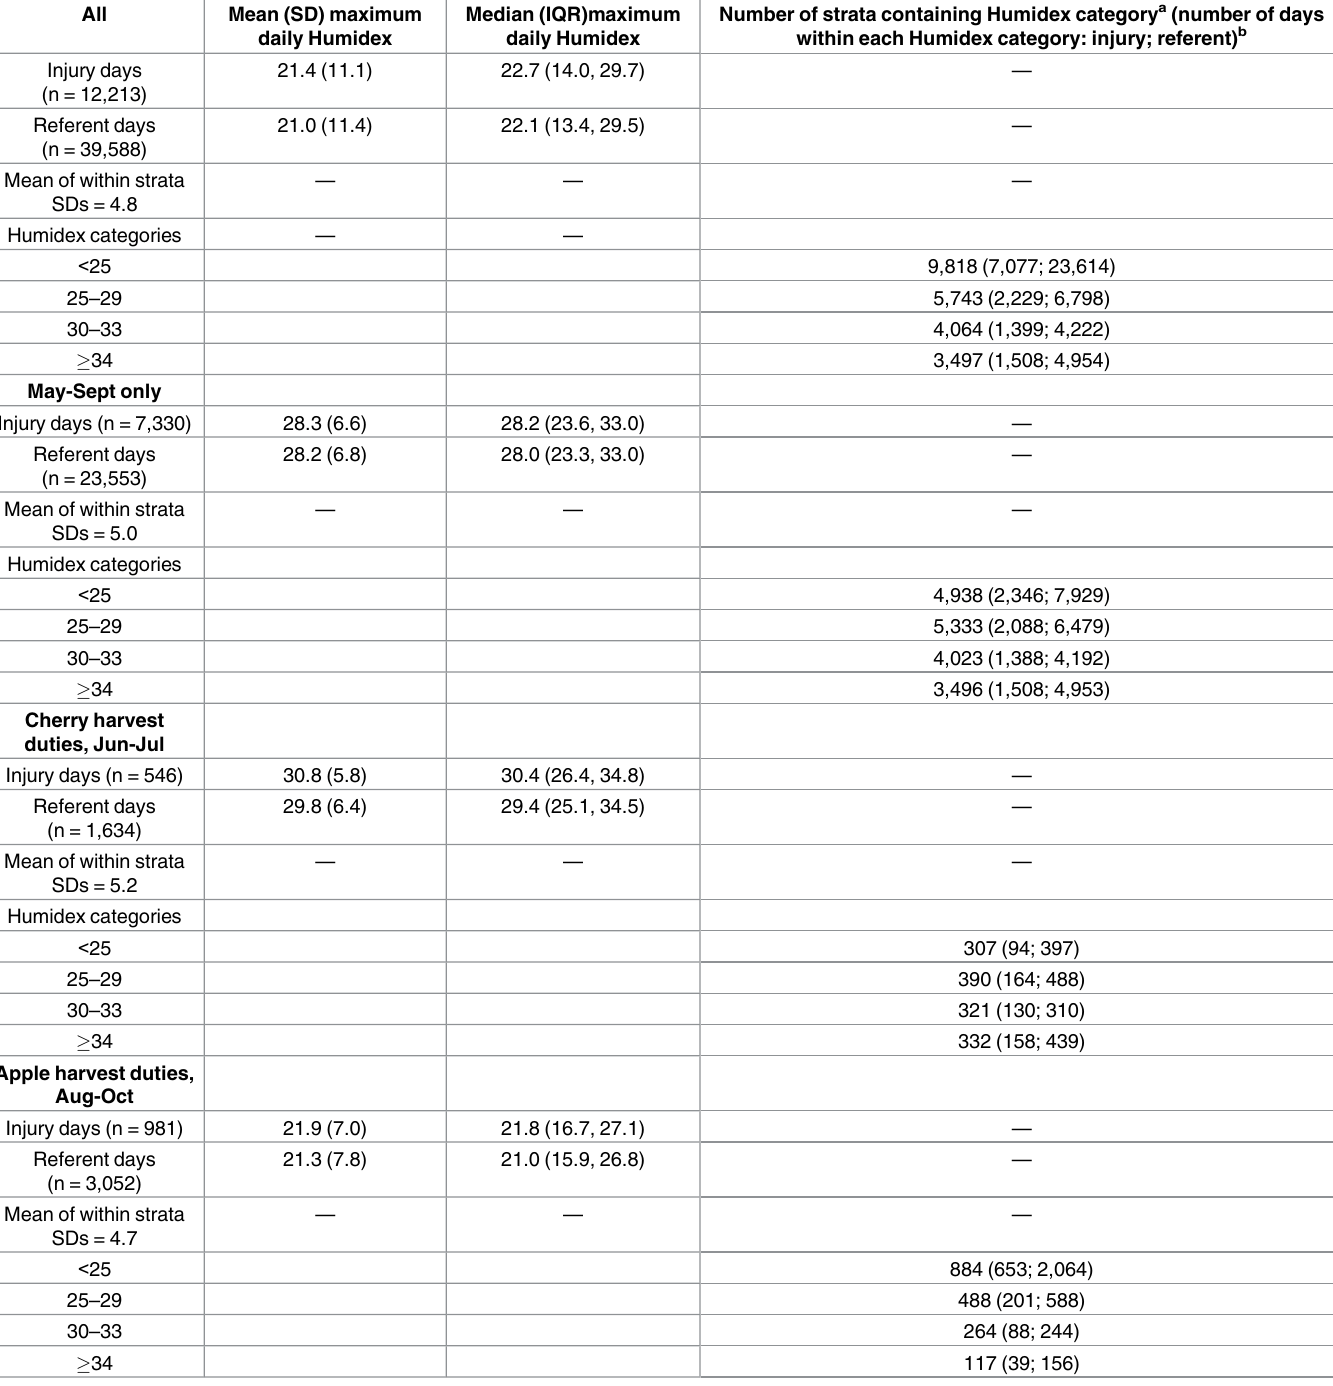
Table 2. Maximum daily Humidex characteristics for adult outdoor agriculture traumatic injury days and referent